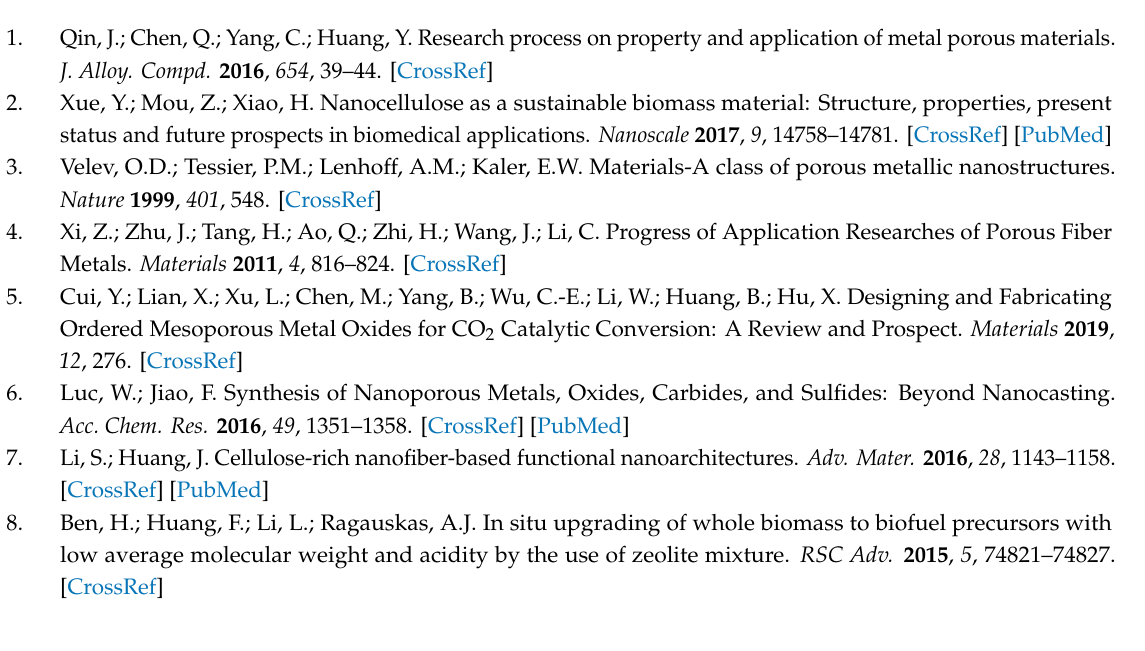
Figure S1: The low resistance and excellent conductivity of paper-templated (A,C) silver and (B,D) gold. Figure S2: The air-laid paper-templated silver fabricated by flame burning. (A) SEM image showing three-dimensional network of the paper–templated silver. An enlarged SEM image of the red square is shown in (B). (C) XRD pattern of the paper–templated silver (black) and the PDF card of silver (PDF#04-0783) (red). Figure S3: Digital photographs of silver fabricated from biomass templates: (A) medical absorbent cotton, (B) seed balls of oriental plane and (C) catkins of reed. Figure S4: XRD patterns of silver fabricated from biomass templates: medical absorbent cotton (black), seed balls of oriental plane (blue), petals of peachblossom (pink), and catkins of reed (purple) with PDF card of silver (PDF#04-0783) (red). Figure S5: Photocatalytic performance of paper-templated silver. (A) The tea bag-like stainless steel mesh for containing the paper-templated silver in the photocatalytic test. (B) Digital photograph of MO solutions after irradiating for every 15 minutes in the presence of the paper-templated silver. (C) Plot of C / C 0 vs time with and without NaBH 4 in the presence of the paper-templated silver. Figure S6: SEM images of (A) the purchased Ag foil and (B) paper-templated silver. Figure S7: Catalytic performance of paper-templated silver under dark condition. (A) A digital photograph of MO solutions in every 15 minutes without paper-templated silver. (B) A digital photograph of MO solutions in every 15 minutes in the presence of the paper-templated silver. Figure S8: More digital photographs of four samples against (A) MRSA and (B) E. coli in agar dishes. The four samples are (1) the paper-templated silver, (2) the paper-templated silver used for the second time, (3) pure silver foil, and (4) paper. Table S1: The degradation e ffi ciency of paper-templated silver compared with other